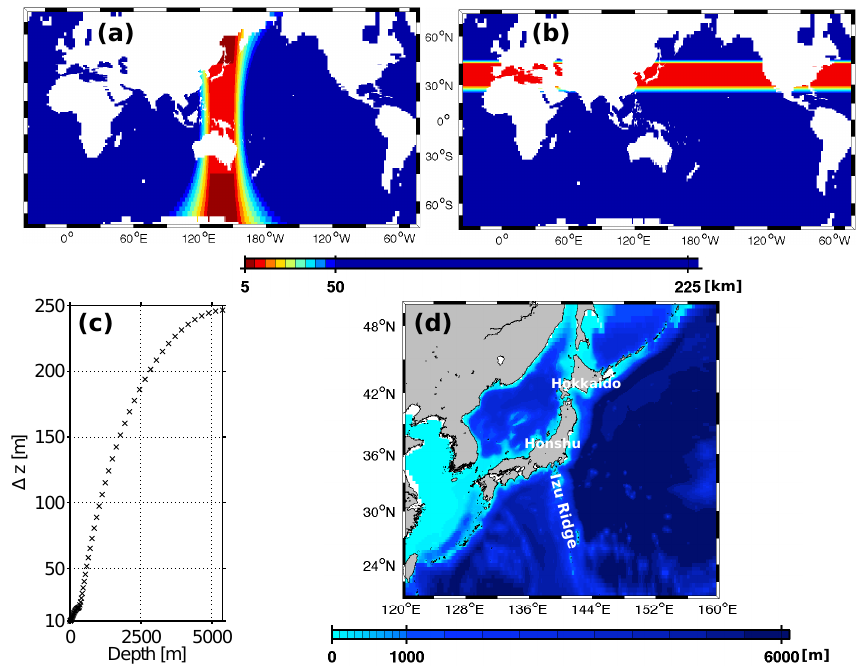
Fig. 1. Model grid. Panels (a) and (b) are horizontal and meridional resolution, respectively. Panel (c) shows the vertical resolution 1z as a function of depth. Panel (d) shows the model bathymetry in the region of interest (white areas are considered as land by the model while the grey patches outline the actual land